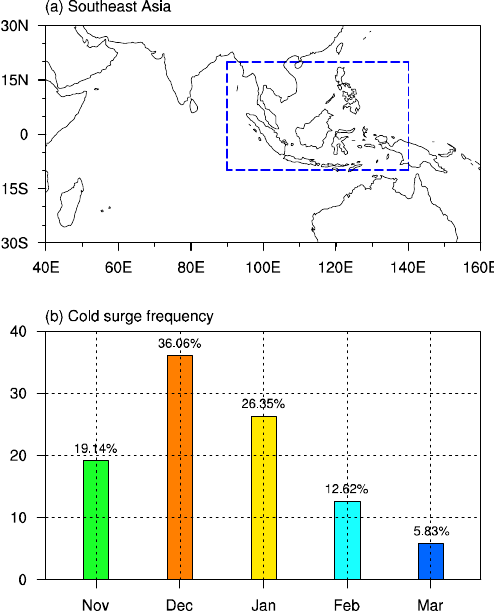
Figure 1. ( a ) Study area of Southeast Asia (10°S–20°N, 90°–140°E) indicated by the blue rectangle. ( b ) Frequency distribution (unit: %) of cold surge days for each winter month during 1998–2018.